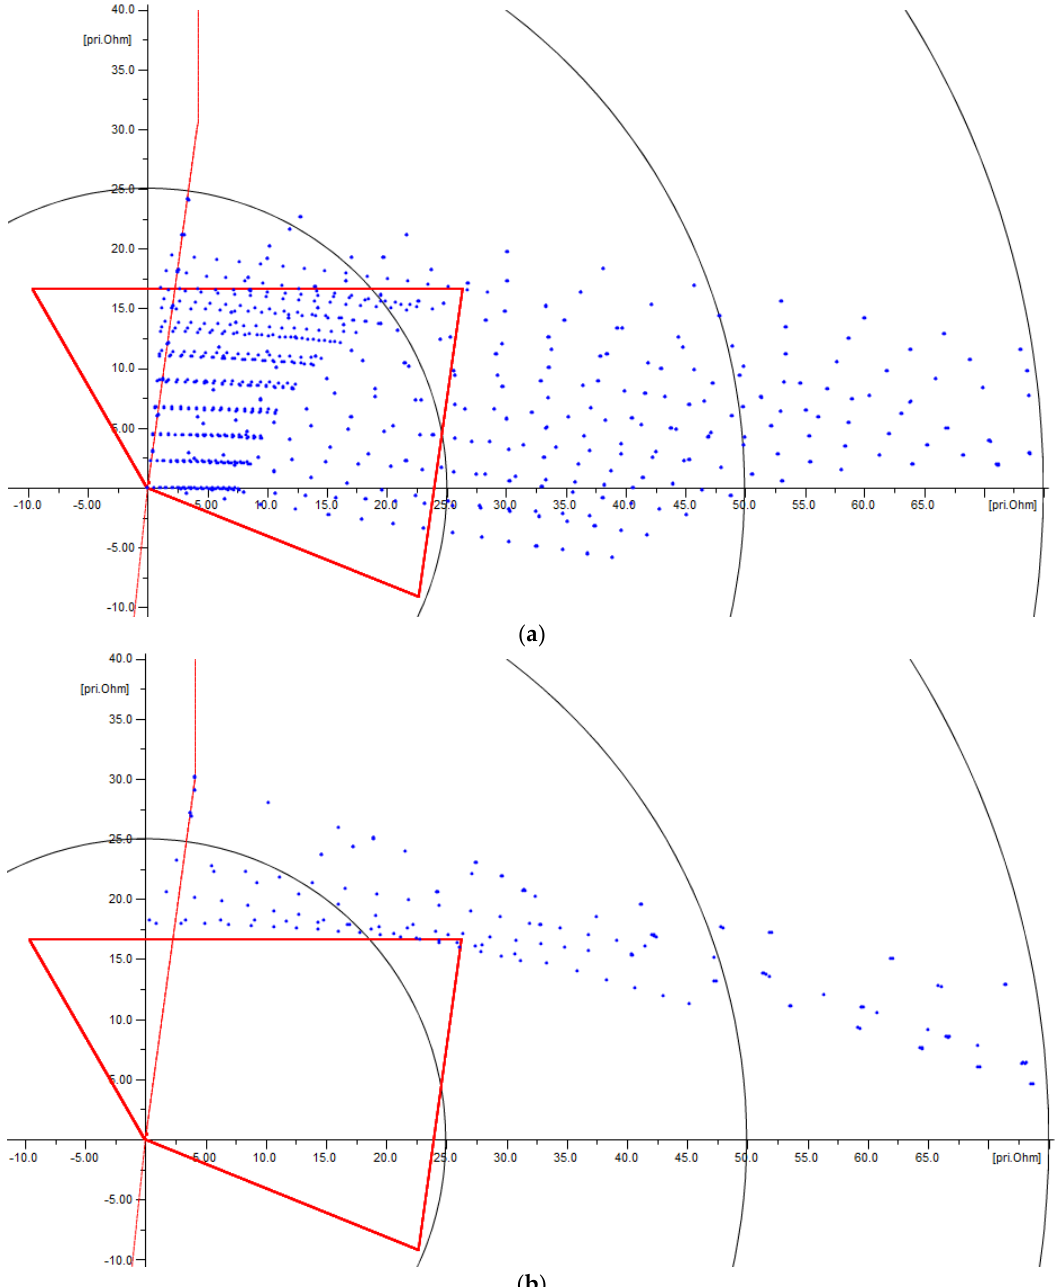
Figure 14. Calculated Zone 1 settings with a preference factor of 0.95, and measured loops for faults grouped in ( a ) set D 1 for Zone 1 calculation, and ( b ) set F 1 for Zone 1 calculation.